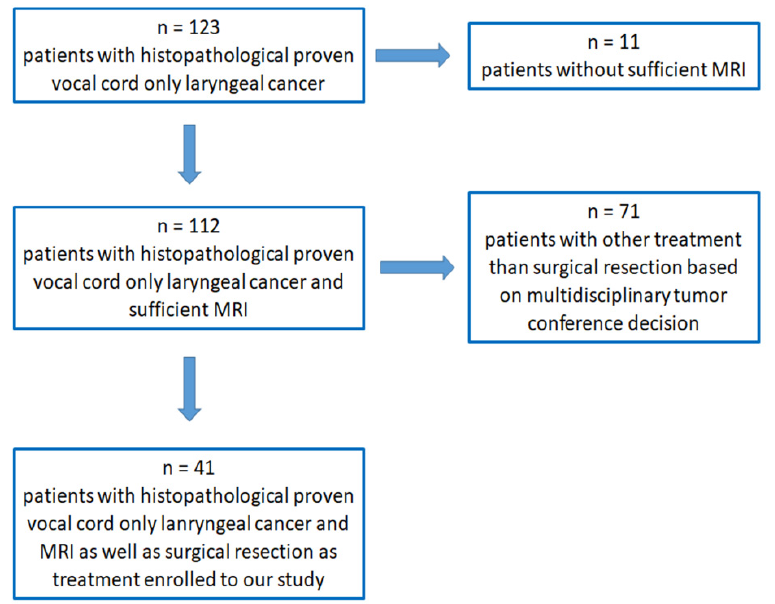
Figure 1. Scheme of enrolled patients with histopathologically proven vocal cord-only laryngeal early-stage cancer (pT1a) for further analysis.